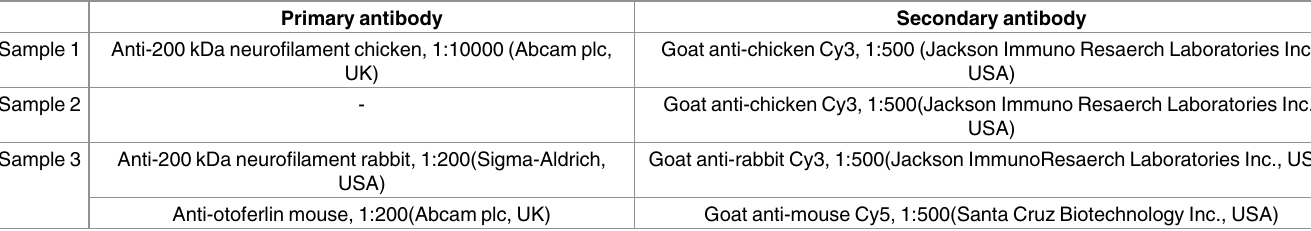
Table 1. Used primary and secondary antibodies are listed with dilution ratio for the individual